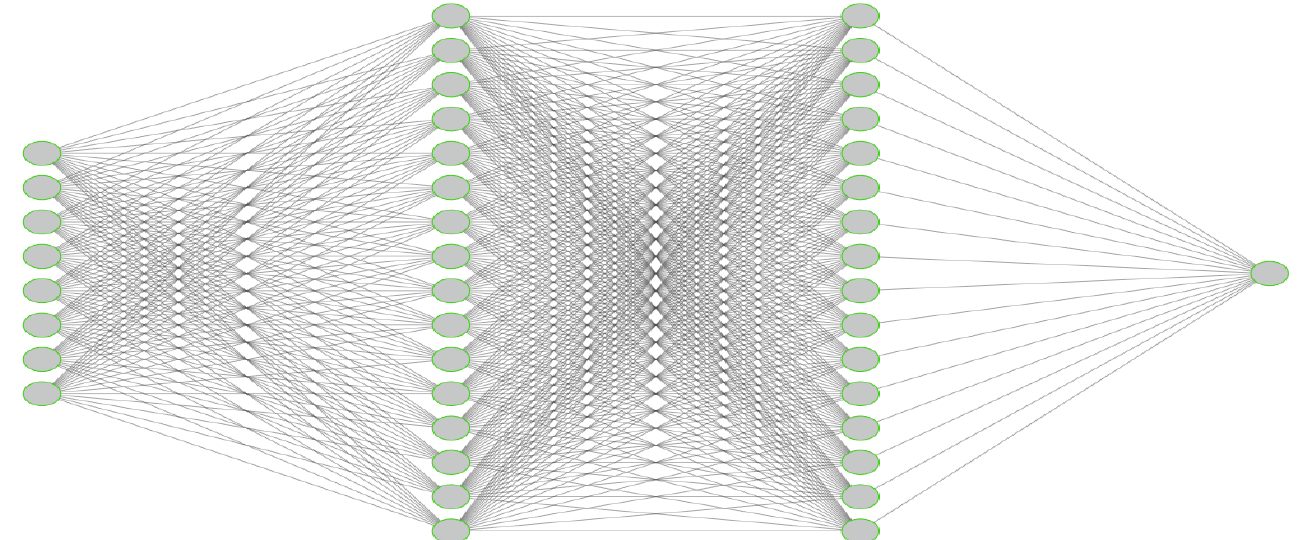
Figure 11. Fully Connected Representation of The Neural Network Architecture (Number of Units Divided By 2 For Visibility).